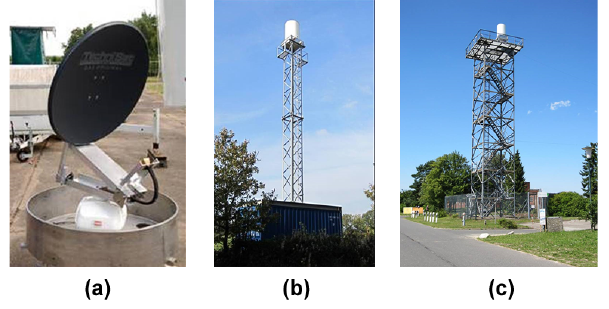
Figure 2. Modified ship navigation radar with parabolic dish (a) , typical radar tower in Quarnstedt (b) and radar at Hungriger Wolf (c)